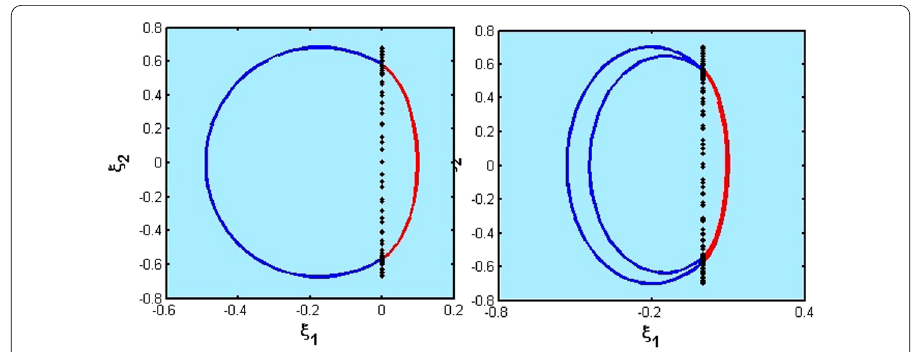
Figure 1 Transition of a period-one orbit to period-two orbits in nonlinear system